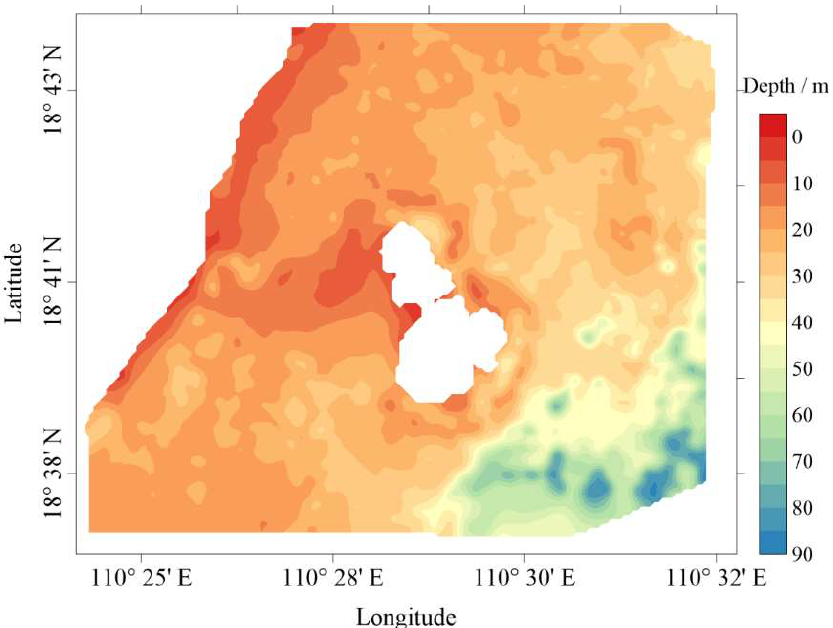
Figure 9. The topography retrieved from MSSTD. It was produced by interpolation of the valid water depths. The upper left and center blank areas were land and Dazhou Island, respectively.